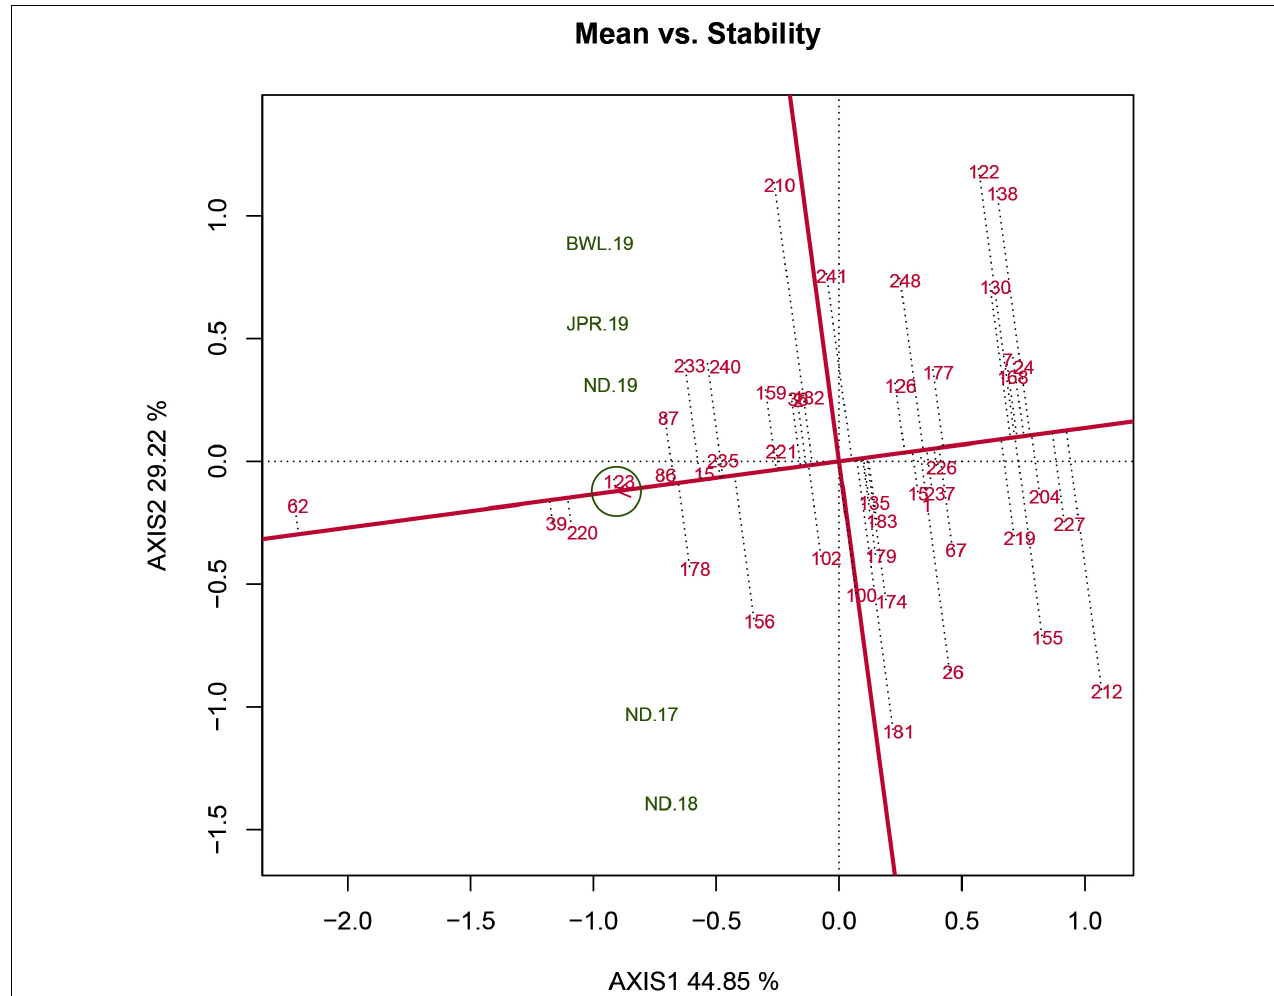
FIGURE 5 | Mean vs stability view of the GGE biplot of 43 resistant genotypes across five testing environments. There was heritability-adjusted scaling of data where the environment standardized data were multiplied by the heritability in each environment (transform = HA), and data were centered by means of the environments (centering = 2). The biplot was based on “row metric preserving” [singular value partition (SVP) = 1], which means that the singular values were partitioned into the genotype eigenvectors for visualizing the correlation among genotypes. Numbers correspond to genotypes as listed in Supplementary Table 1 . Environment: ND-17, New Delhi-2017; ND-18, New Delhi-2018; ND-19, New Delhi-2019; BWL-19, Bawal-2019; JPR-19, Jaipur-2019.